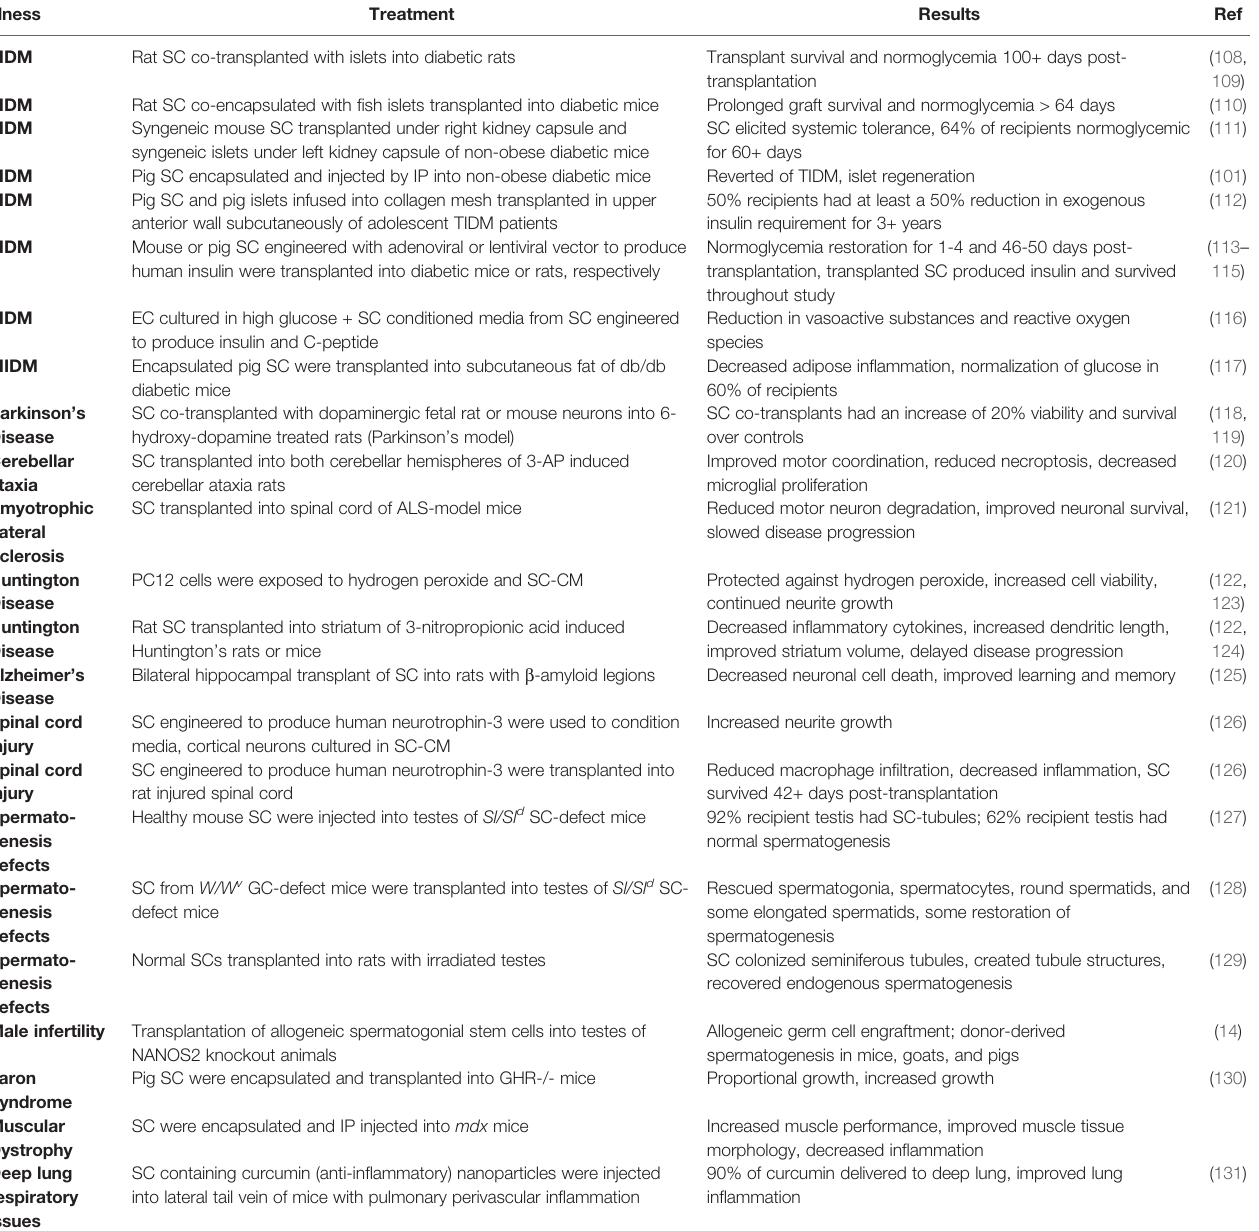
TABLE 2 | SC therapeutics. Illness Treatment Results Rat SC co-transplanted with islets into diabetic